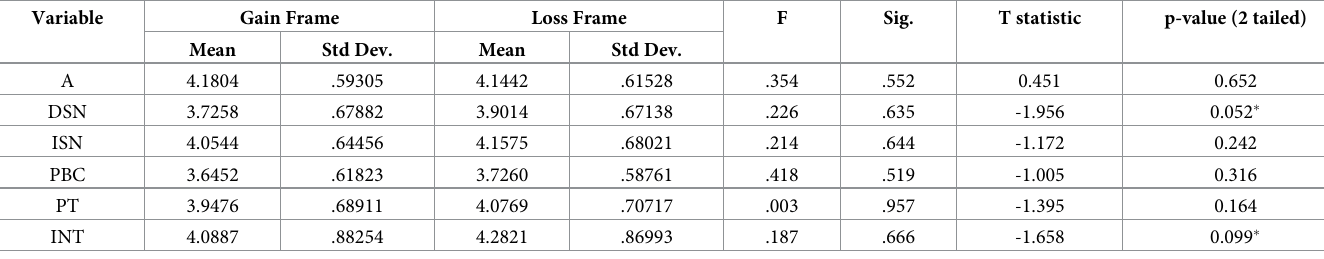
Table 9. Independent-sample T test.